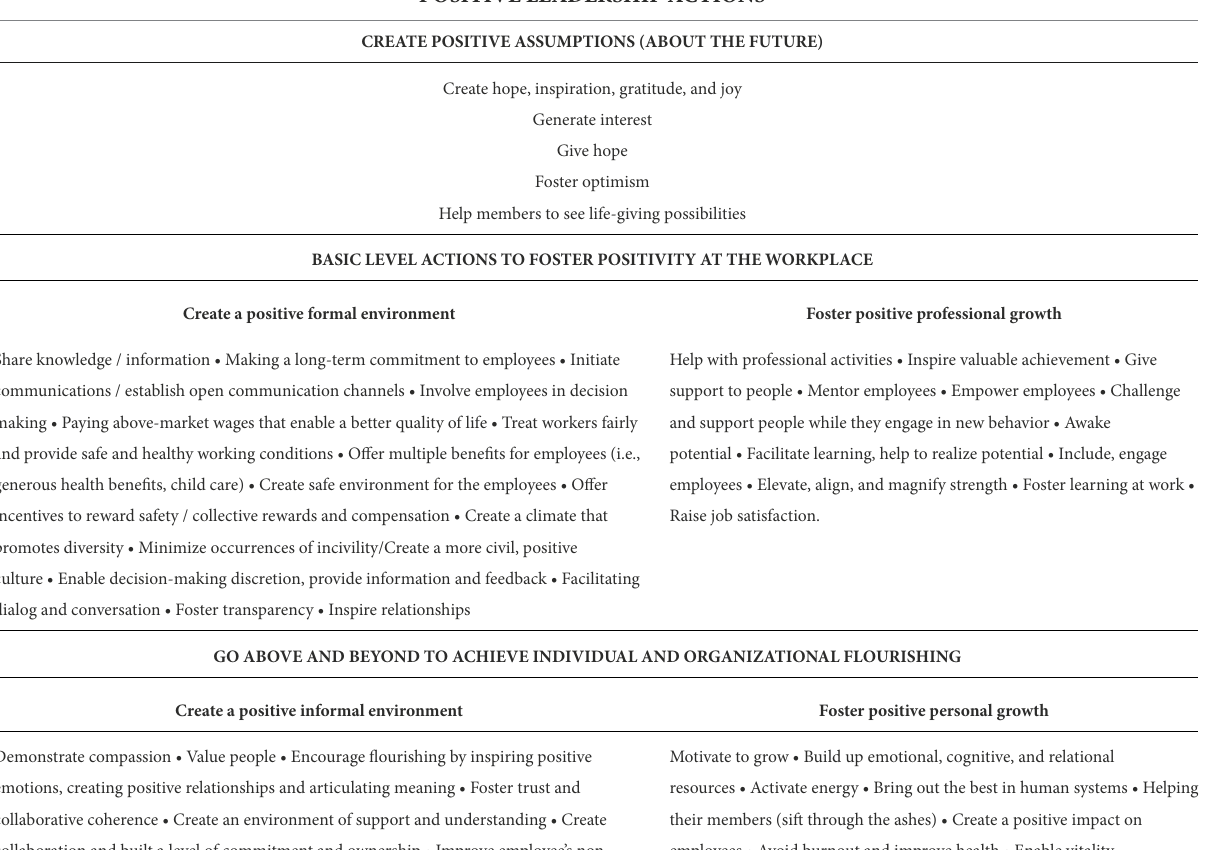
TABLE 1 Positive leadership